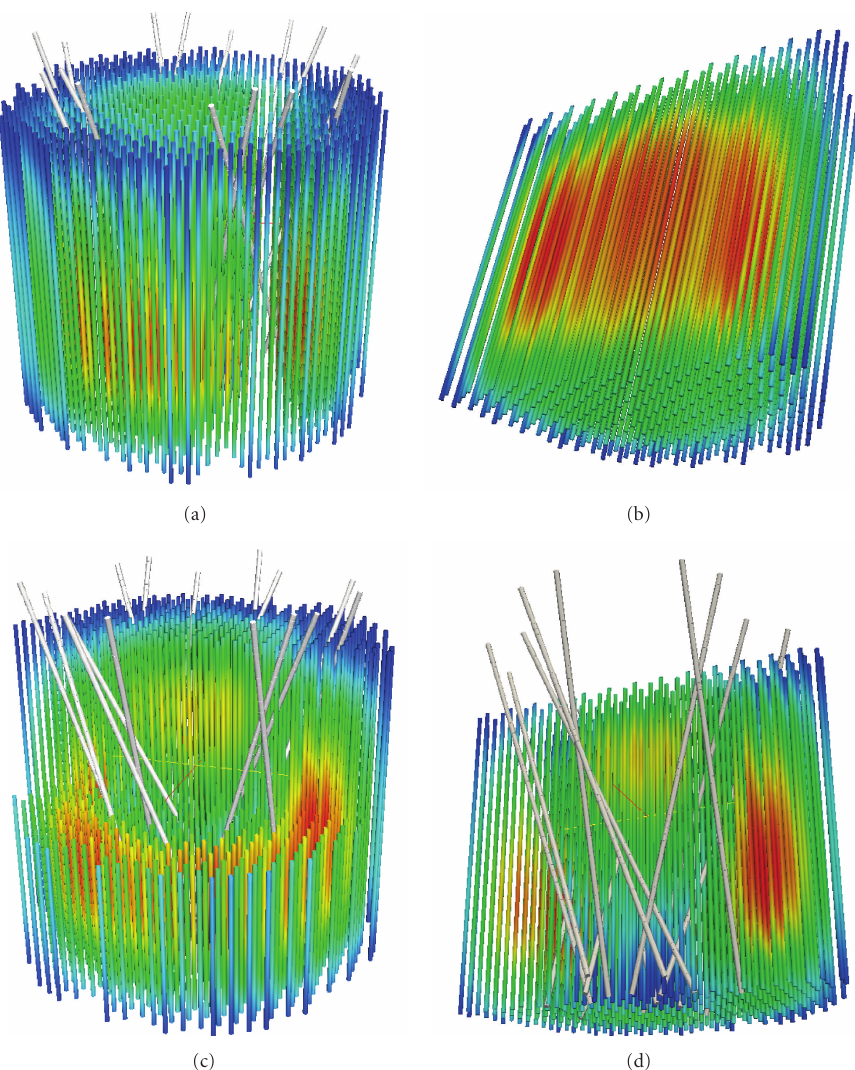
Figure 7: Example of instantaneous thermal power distributions that can be obtained with DyPRA. (a) Power distribution at 100% with control rods in nominal position. (b) Cutaway view of figure (a) (control rods not shown). (c) Normalised power distribution during a reactor scram. (d) Cutaway view of figure